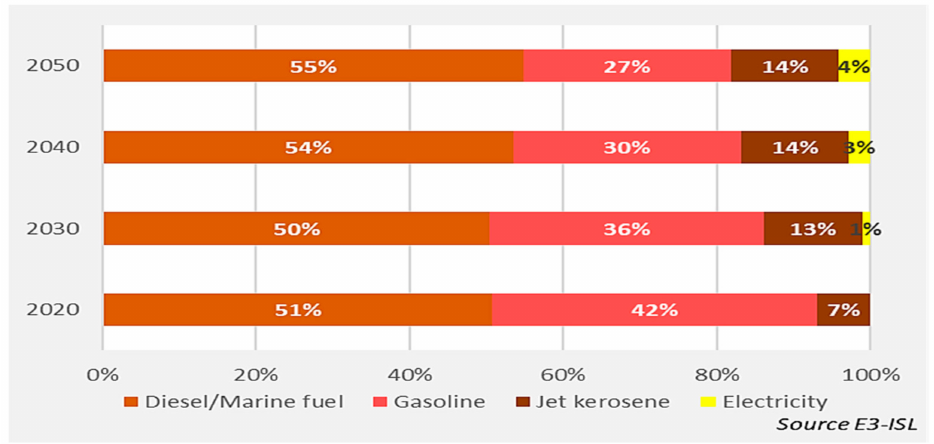
Figure 4. Baseline scenario—evolution of fuel mix in transport over